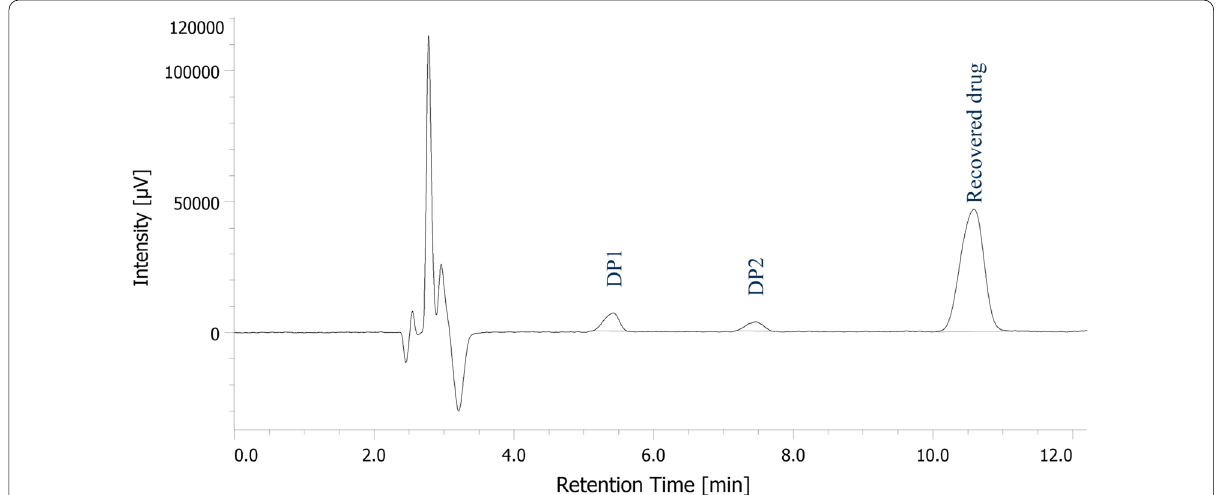
Fig.3 Chromatogram of the recovery study carried out at a spiked concentration of 120 µg mL − 1